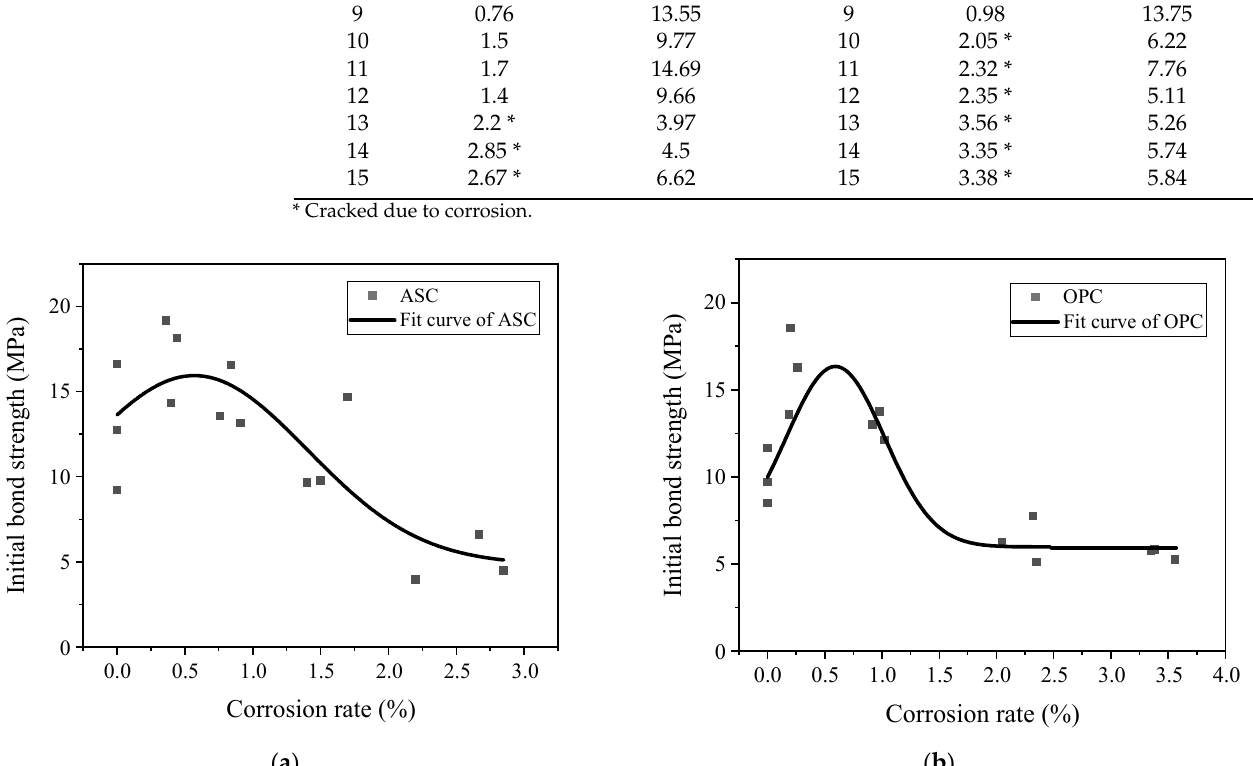
Figure 9. Corrosion degree and initial bond strength: ( a ) ASC and ( b ) OPC.